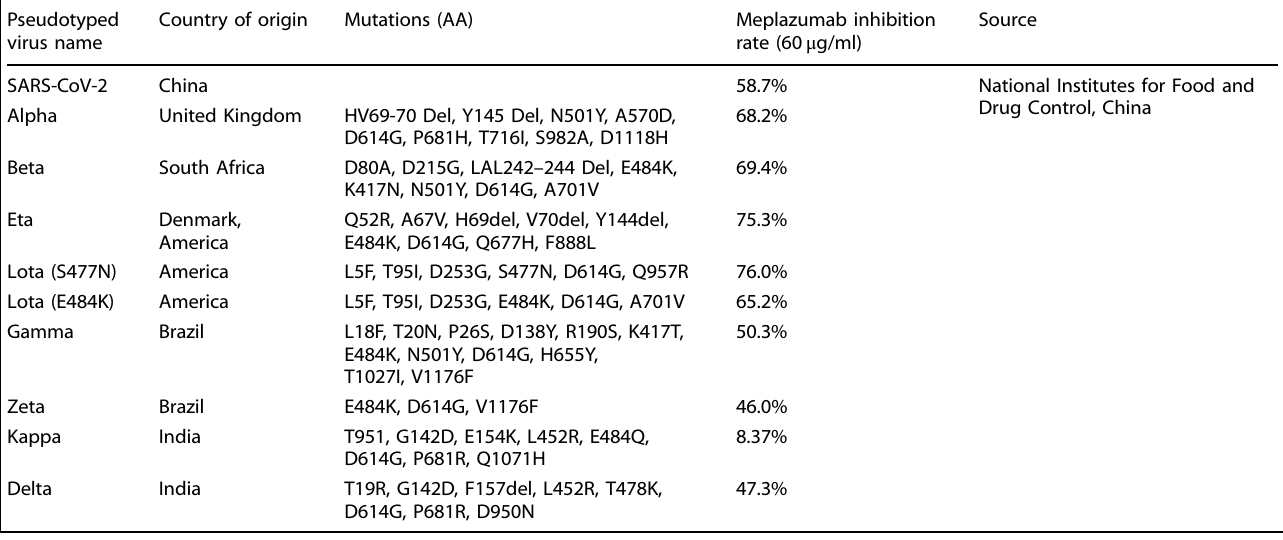
Table 4. SARS-CoV-2 pseudotyped variants features and CD147 antibody inhibition rate